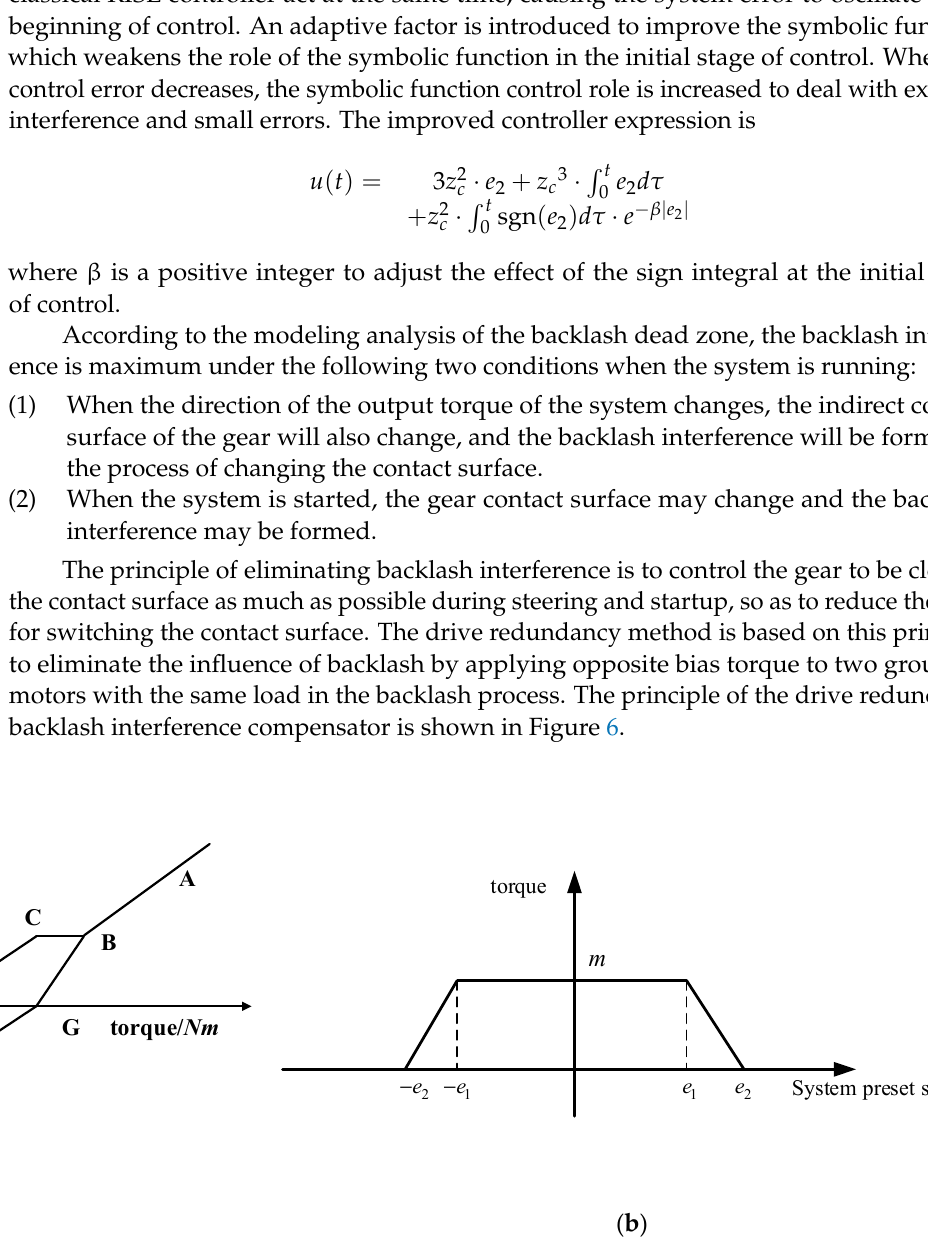
Figure 6. Schematic diagram of drive redundancy control. ( a ) Motor torque diagram; ( b ) Schematic diagram of offset force.